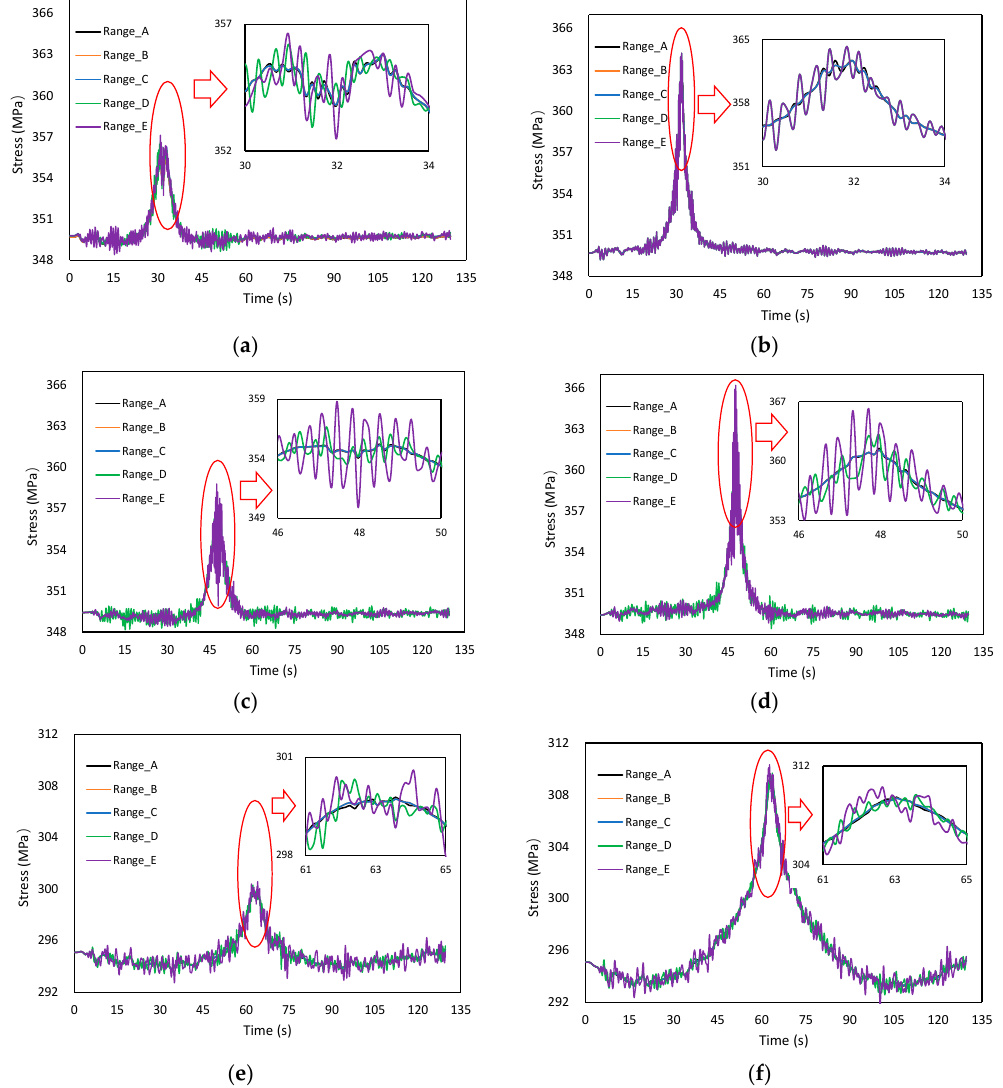
Figure 14. Time-dependent laws of suspender stress with different road roughness. ( a ) Suspender A, ( b ) Suspender B, ( c ) Suspender C, ( d ) Suspender D, ( e ) Suspender E, ( f ) Suspender F.